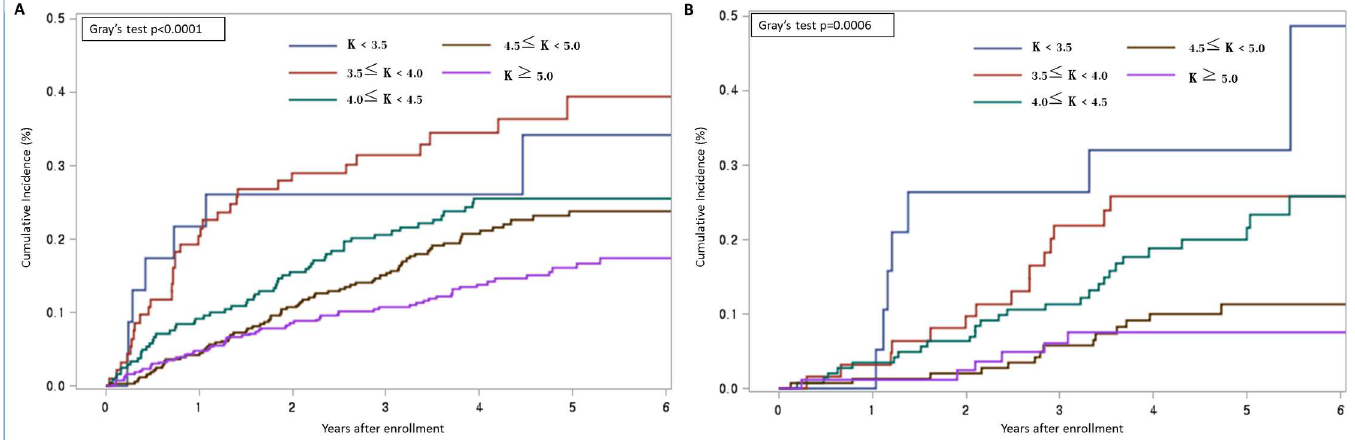
Fig 3. Cumulative mortality incidence in patients with end-stage renal disease undergoing hemodialysis (A) or peritoneal dialysis (B). Mortality incidencewas plotted accordingto the level of serum potassium.